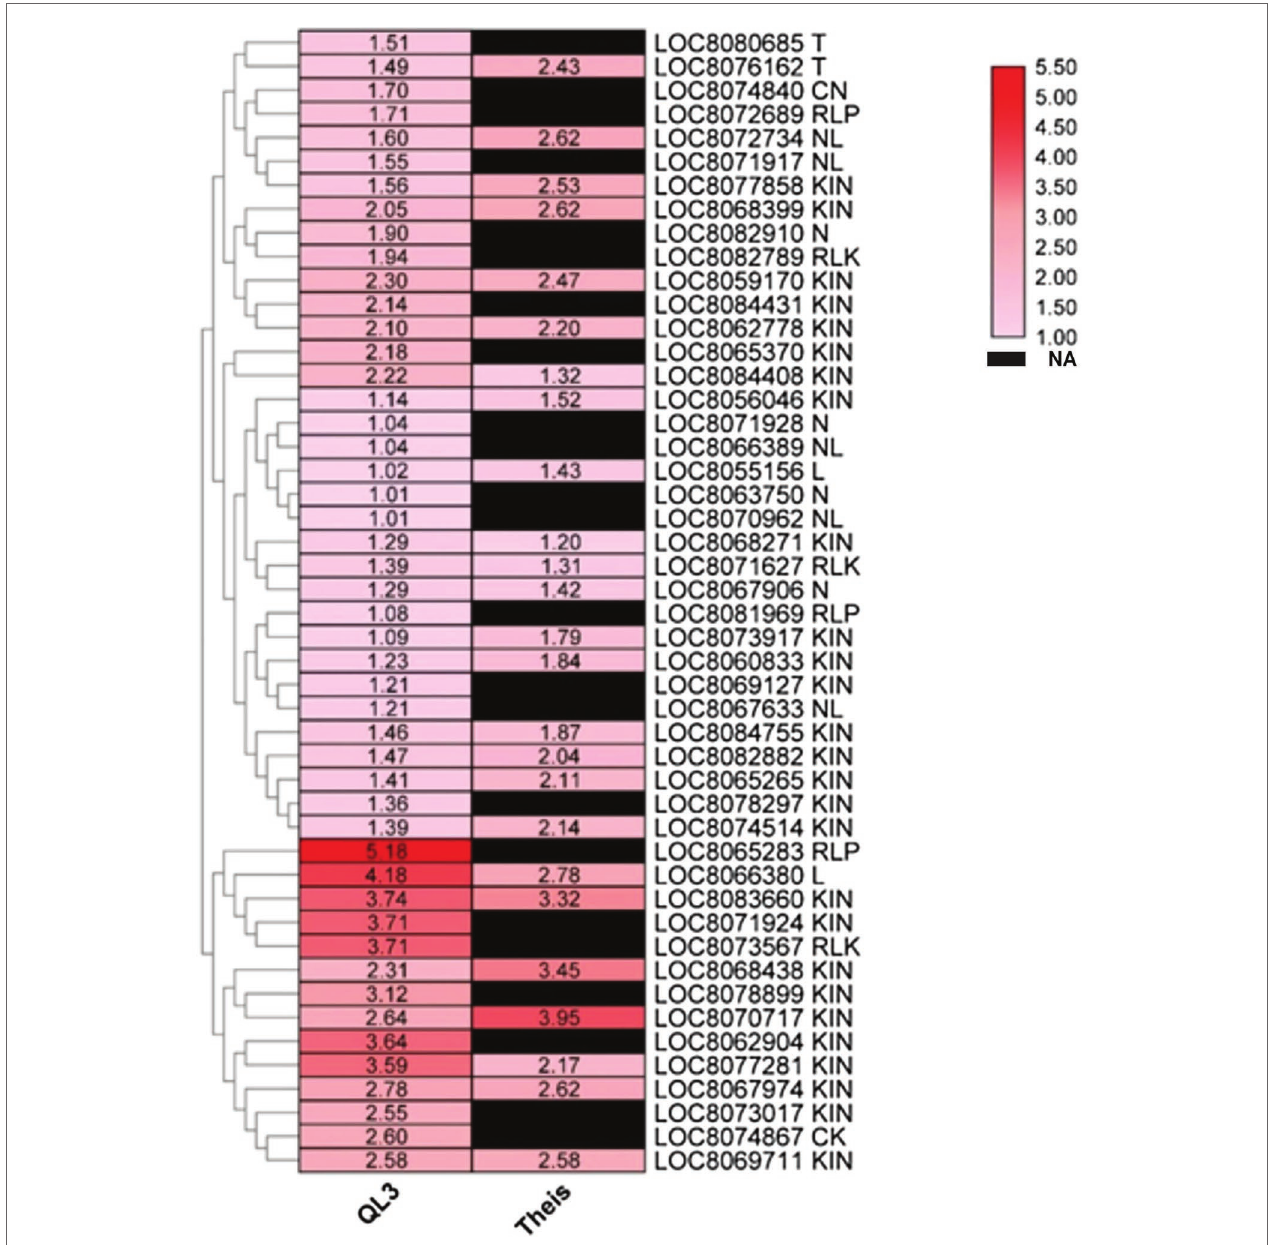
FIGURE 5 | Heatmap shows the expression of DEGs for plant disease resistance in resistant (QL3) and susceptible (Theis) genotypes upon Johnsongrass anthracnose infection. Plant disease resistance genes (R-genes) and their classes are included in the gene name. Gene expression values are presented as log 2 Fold Change. “NA” denotes no DEGs found in a respective